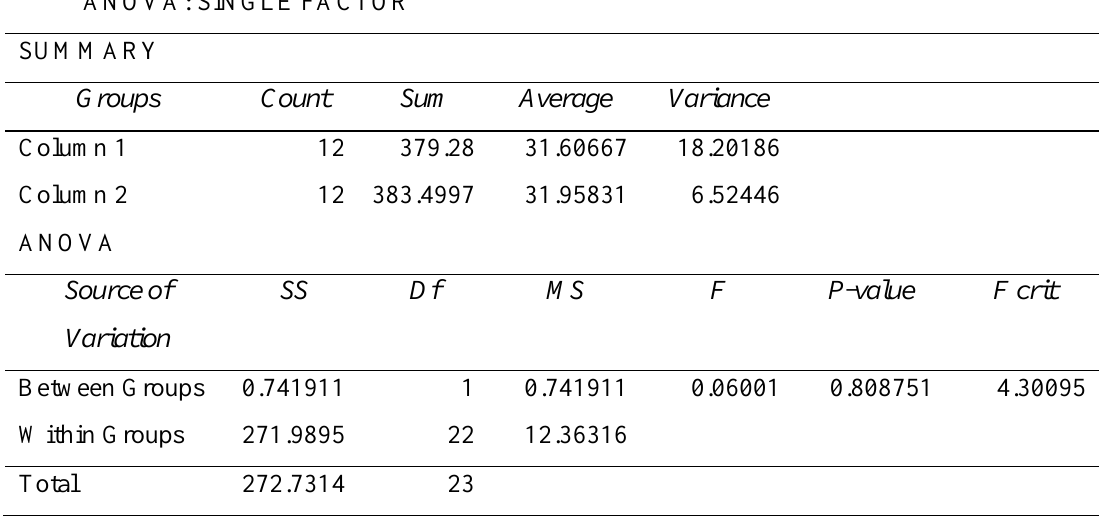
ANOVA Analysis for Iroko.